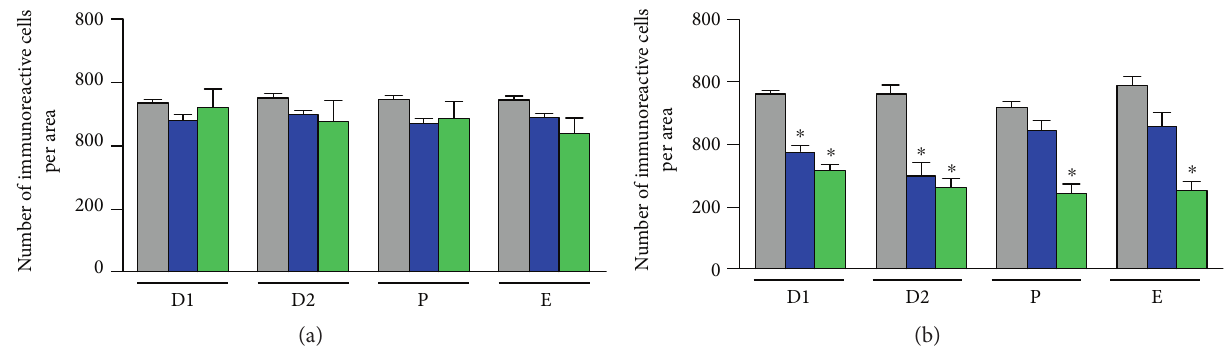
Figure 3: Number of m AChR or m AChR immunostained neurons (m AChR-ir or m2AChR-ir) in the POA-AHA region throughout the 1 2 1 oestrous cycle in the rat. A number of m AChR-ir (a) or m AChR-ir (b) were counted on both sides (left side plus right side) of the medial 1 2 preoptic nucleus in the preoptic region at 9:00 (grey bar), 13:00 (blue bar), or 17:00 h (green bar) for each phase of the oestrous cycle. The results are expressed as the mean ± SEM. ∗ p < 0 05 versus 9:00h, for its respective phase of the oestrous cycle. D1, dioestrous-1; D2, dioestrous-2; P, proestrous; E, oestrous.